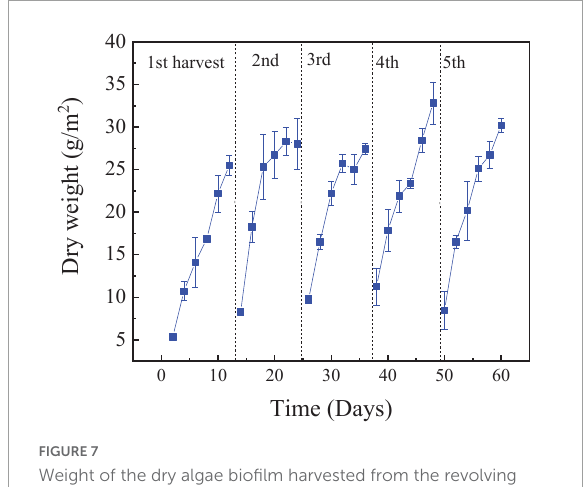
FIGURE7 Weight of the dry algae biofilm harvested from the revolving algae-bacteria biofilm cathode in a photosynthetic membrane-free microbial fuel cell (RAB-MFC) cathode reactor. Influent chemical oxygen demand (COD) was 1,200